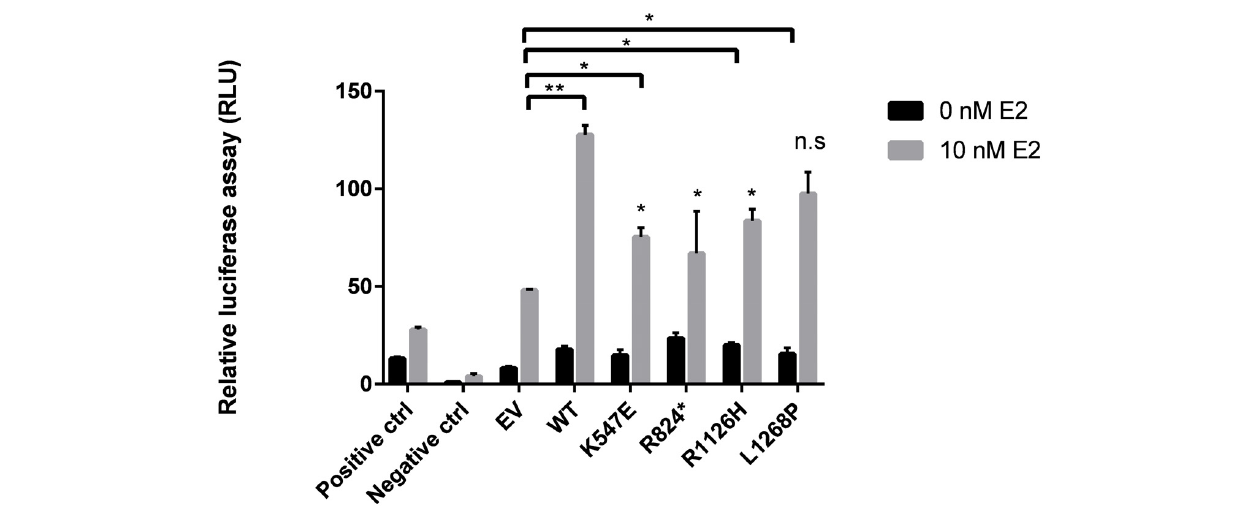
FIGURE 5 | Effects of WHSC1 mutations on transcriptional activation of Estrogen Receptor Gene (ER α ). WT WHSC1 showed increase in ERE-mediated luciferase activity relative to EV. K547E, R824X, and R1126H were associated with reduced ability to activate ER activity, compared to WT. Whereas L1268P activated ER activity comparable to WT (n.s.). Data are presented as mean values ± SD, n = 2.